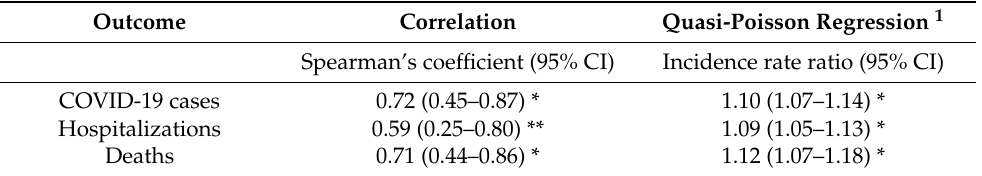
Figure 1. Percent of seropositive workers compared to the cumulative incidence of ( A ) PCR-confirmed COVID-19 cases, ( B ) COVID-related hospitalizations, and ( C ) deaths due to COVID-19 in nursing home residents. Each nursing home is represented by one point in the graphs. The size of dots is proportional to the number of workers with a serological test in each nursing home. Blue lines and envelopes represent quasi-Poisson regression model predictions and corresponding 95% confidence intervals. Table 2. Correlation and quasi-Poisson log-linear regression results of the association between cumulative incidence per 1000 person-days of PCR-confirmed COVID-19 cases, COVID-19-related hospitalizations, and deaths due to COVID-19 among nursing home residents (outcome variables), and nursing home staff seropositivity (independent variable).